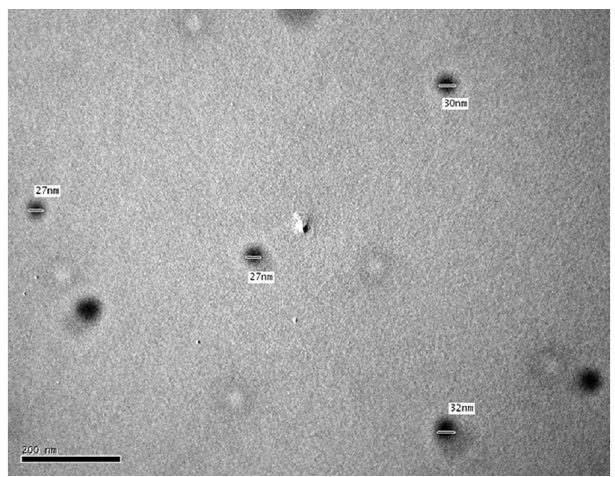
Figure 2. TEM imaging of PEDT